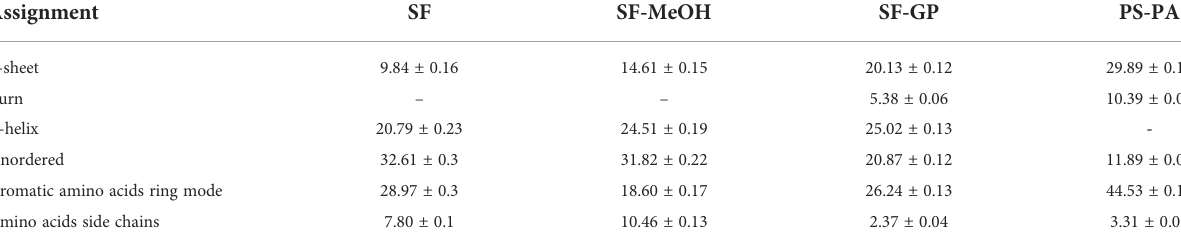
TABLE 3 Quantitative estimation related to protein spatial structure in different preservation methods located at 1,600-1,700 cm -1 .